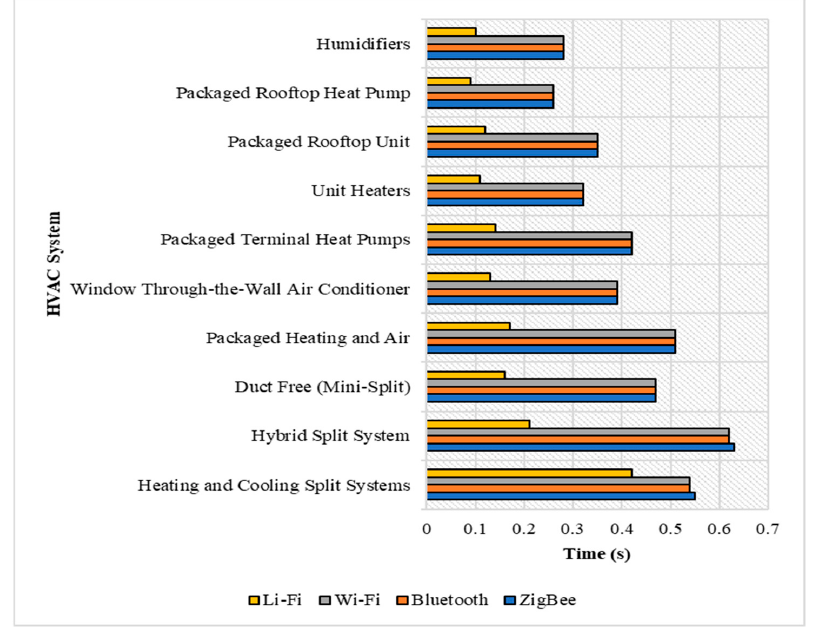
Figure 5. Computational times (s) between various communication protocols using the CRNN